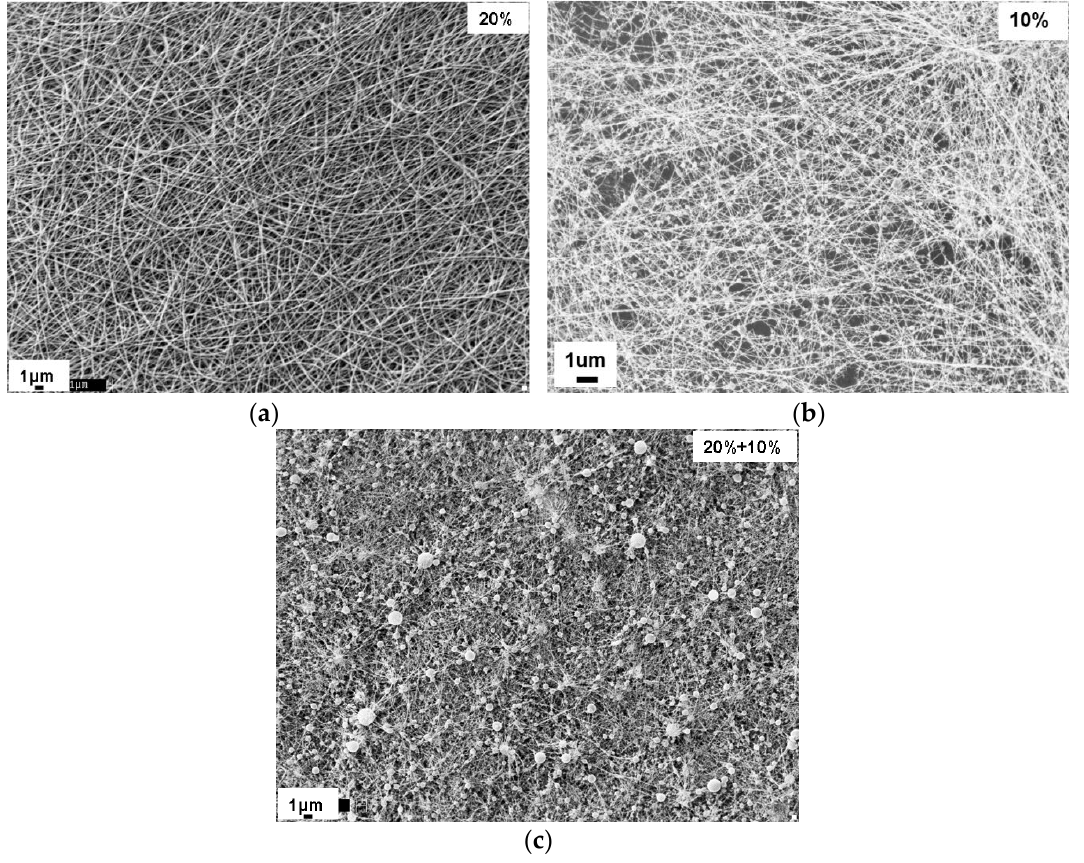
Figure 2. SEM imaging of nylon 6 nanofibers electrospun from ( a ) 20 wt % nylon 6; ( b ) 10 wt % nylon 6; and ( c ) 20 wt % and 10 wt % in 88% formic acid solutions.